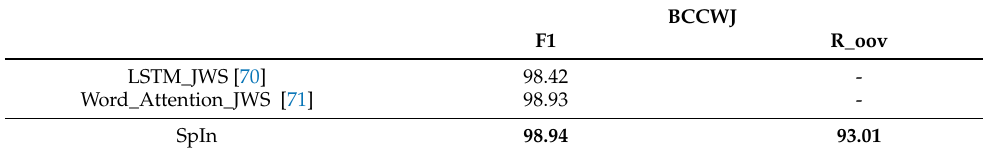
Table 4. Comparison between SpIn and previous state-of-the-art methods on the JWS task.